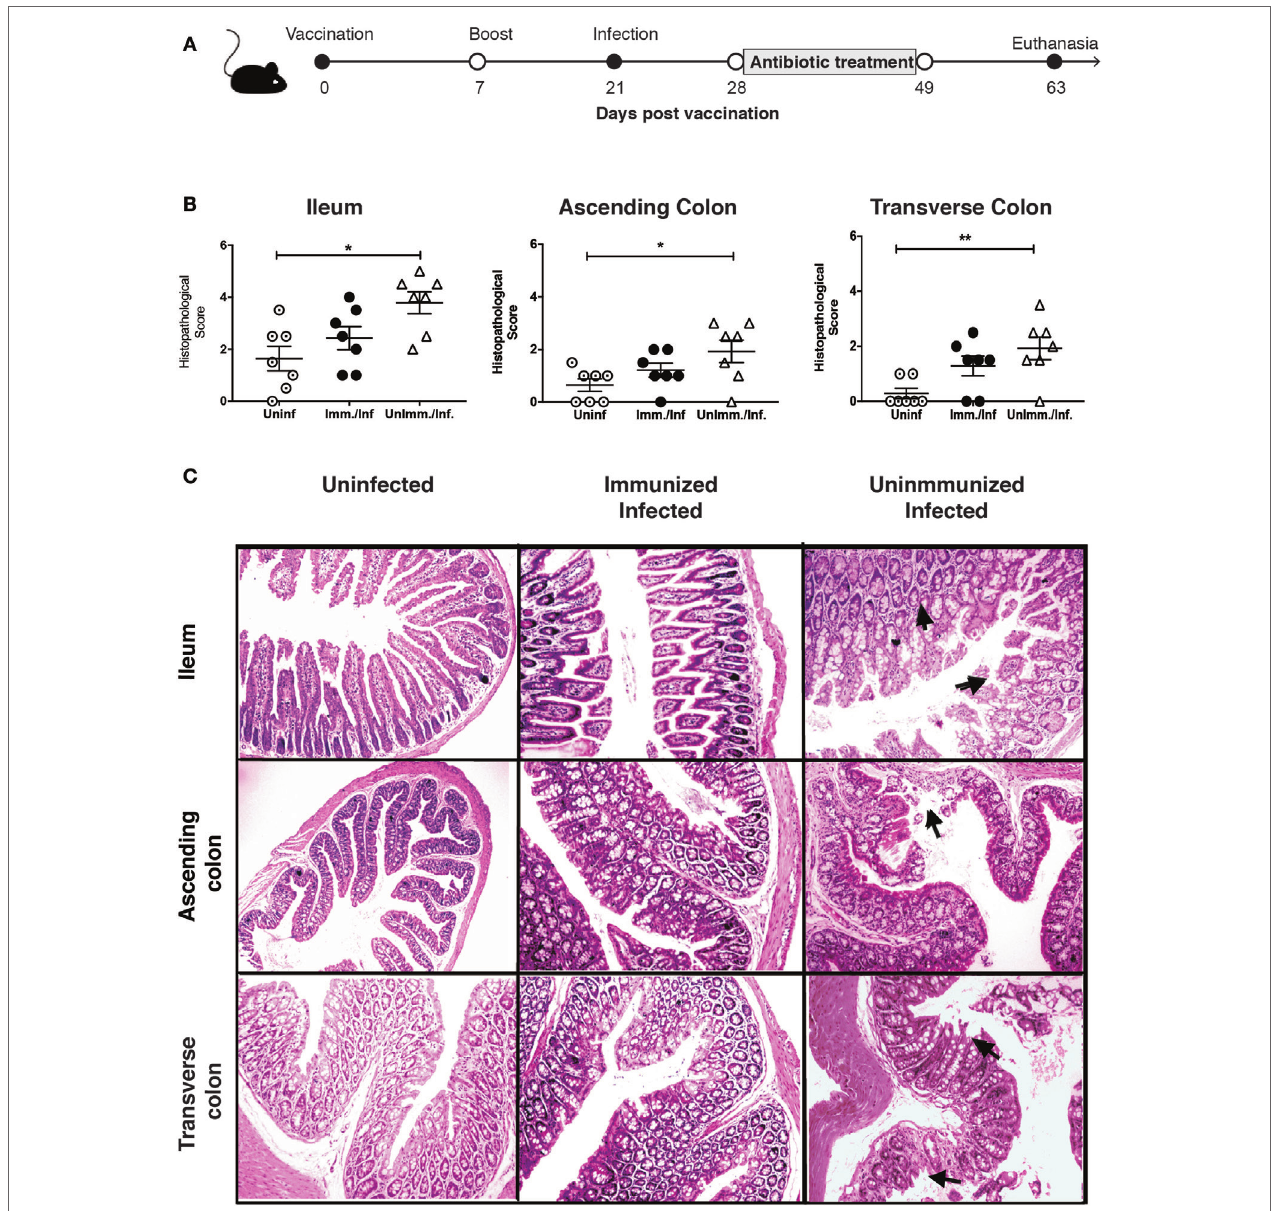
FigUre 5 | Immunization reduces the increased susceptibility of interleukin (IL)-10 − / − for intestinal inflammation due to previous Salmonella enterica serovar Typhimurium ( S . Typhimurium) infection. (a) IL-10 − / − mice were immunized with 1 × 10 6 CFU of attenuated S. Typhimurium strain Δ SPI-2 at day 0 and received a boost at day 14. Subsequently, mice were challenged with virulent S . Typhimurium on day 21. Seven days post-challenge, mice were orally treated with enrofloxacin (2 mg/ml) for 3 weeks, left untreated for 14 days and euthanized at 63 days post-immunization to evaluate spontaneous intestinal inflammation. (B) Average histopathology score for ileum, ascending, and transverse colon of seven IL-10 − / − mice included in each group. (c) Representative images of the intestines of IL-10 − / − mice, unimmunized-uninfected mice, unimmunized-infected and immunized-infected mice (4 µm ileum and ascending colon section stained with H&E and observed in optical microscope at 10 × magnification). Arrows indicate inflammatory cellular infiltration and erosion. Histological score analyzed by one-way ANOVA with Kruskal–Wallis post-test. Data shown are mean ± SEM of two independent experiments with three to four mice per group. * P < 0.05, compared uninfected with immunized-infected or unimmunized-infected